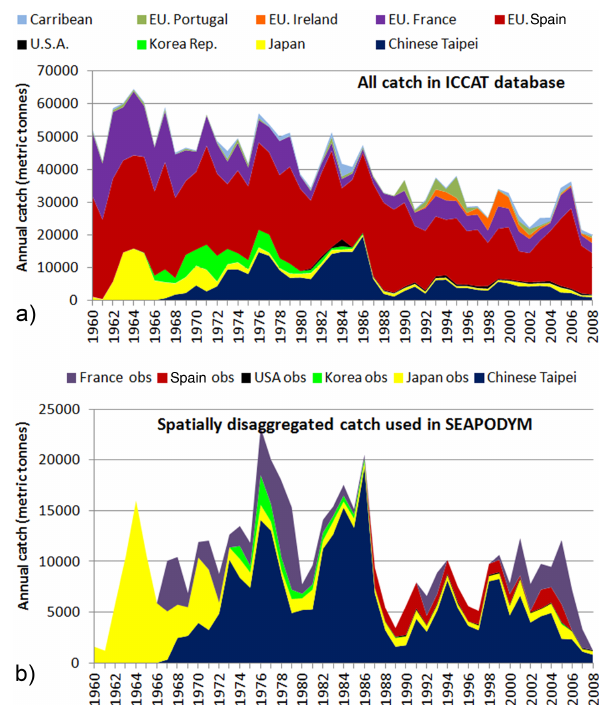
Figure 1. Annual catch of North Atlantic albacore tuna by flag. (a) All aggregated catch declared to ICCAT, and (b) available geo- referenced catch data used with